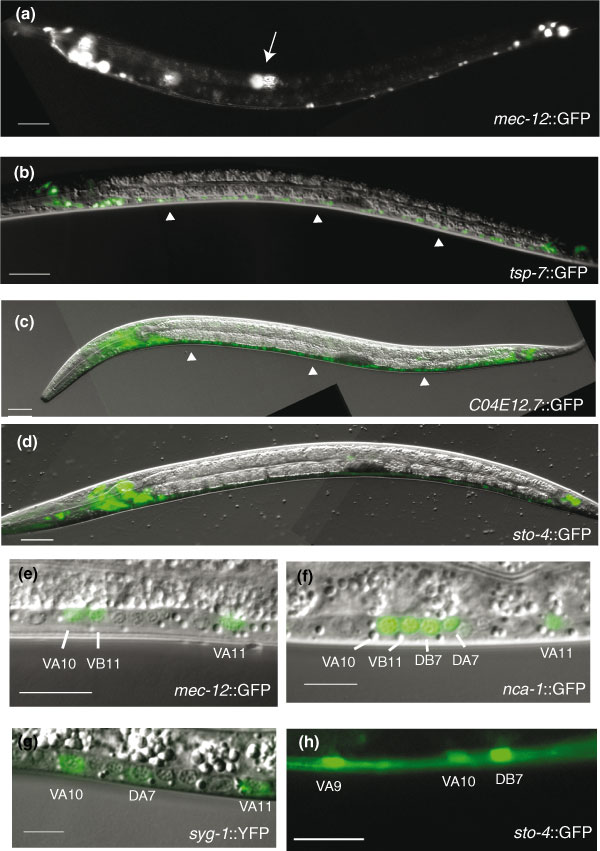
GFP reporters validate neuronal microarray datasets. Transgenic animals expressing GFP reporters for representative genes detected in neuron-enriched microarray datasets. Anterior to left, ventral down. GFP images are combined with matching DIC micrographs for panels (b-g). (a,e) mec-12::GFP is expressed in touch neurons (arrow) and in specific ventral cord motor neurons (e) at the L2 stage. (b,c) tsp-7::GFP and C04E12.7::GFP are widely expressed in the nervous system with bright GFP in head and tail ganglia and in motor neurons of the ventral nerve cord (arrow heads). (d,f,g,h) Note expression of GFP reporters for sto-4, nca-1, and syg-1 in A-class (DA, VA) and in other ventral cord motor neurons (for example, DB, VB).